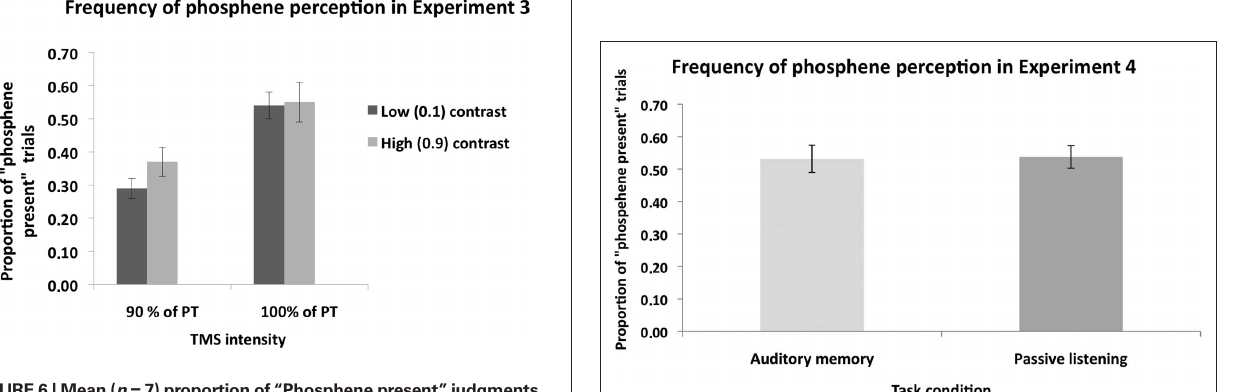
Figure 6 | Mean ( n = 7) proportion of “Phosphene present” judgments in experiment 3. As in Experiment 2, there was no difference in phosphene frequency between the low and high contrast stimuli when TMS was applied at 100% of phosphene threshold. When TMS was applied at 90% of PT, significantly more phosphenes were perceived during high contrast mental imagery than in the low contrast imagery condition, indicating that an increase in contrast enhanced visual cortical excitability. Error bars represent ± 1 SEM.